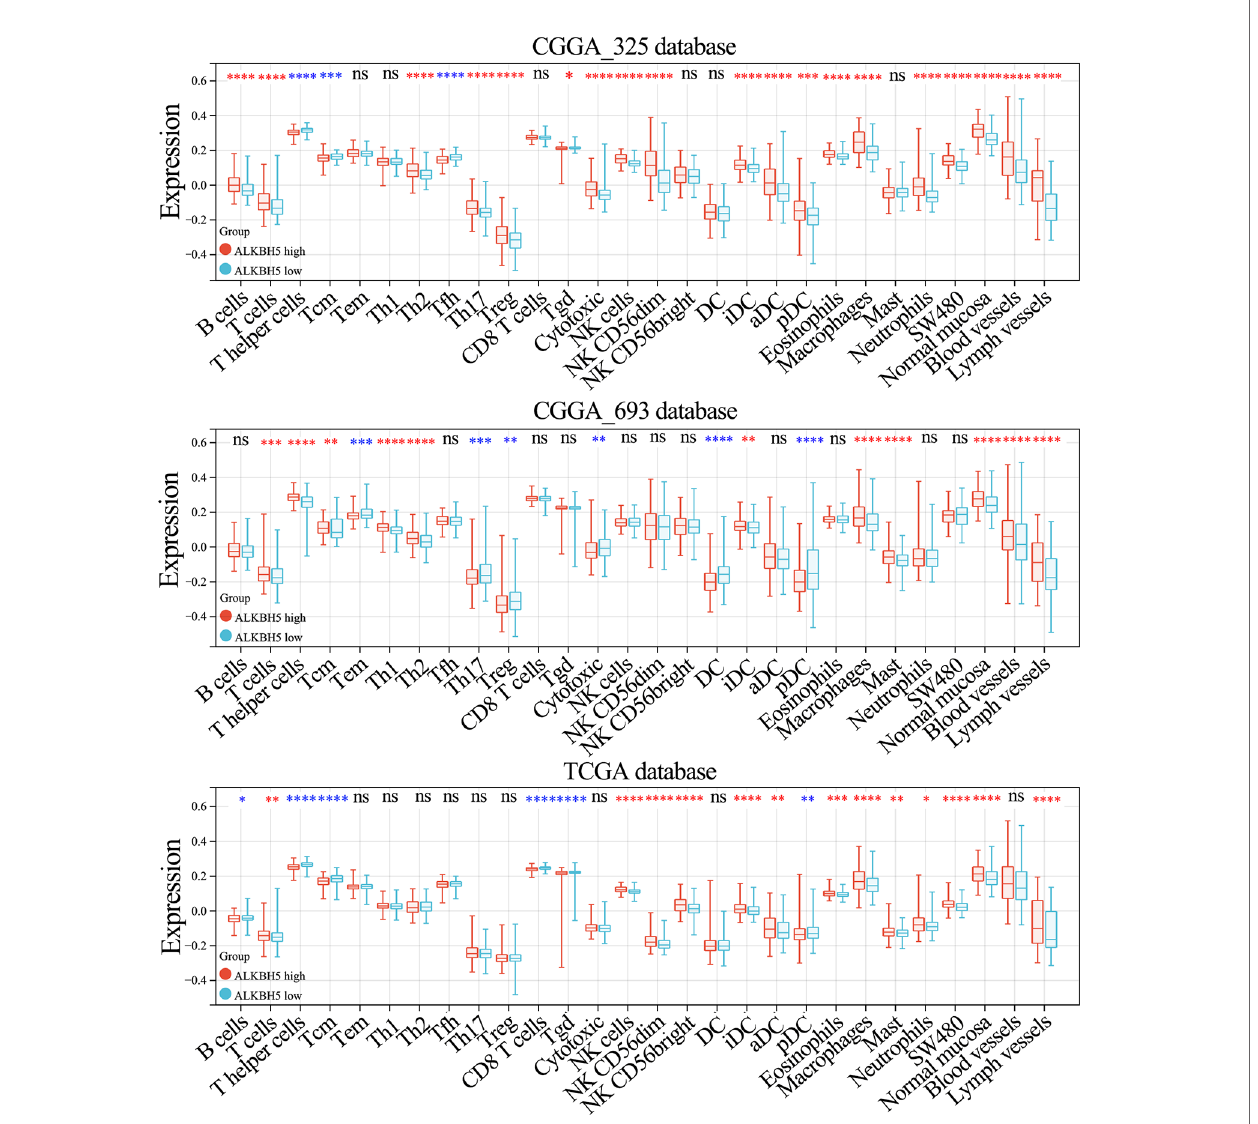
FIGURE 7 | Correlation between ALKBH5 mRNA expression and tumor immune-related cells in glioma. The correlation between ALKBH5 mRNA expression and immune cells types in glioma calculated by xCell algorithm in CGGA_325, CGGA_693 and TCGA datasets. ns (nonsense), * P <0.05, ** P <0.01, *** P <0.001, **** P